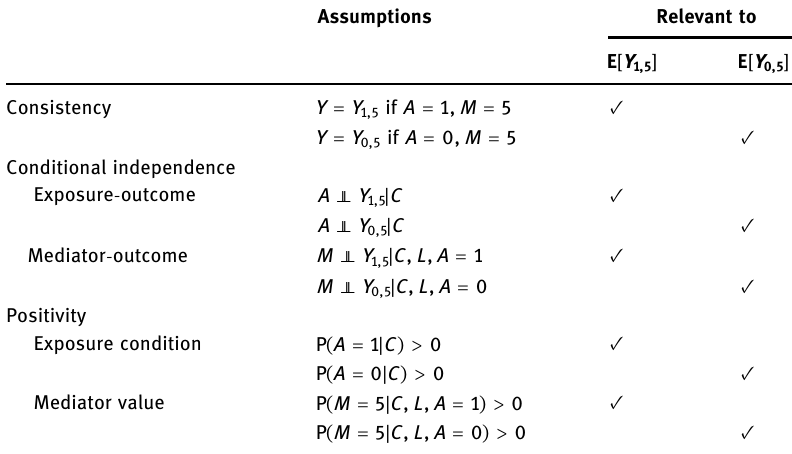
Table 3: Identifying assumptions for CDE ( 5